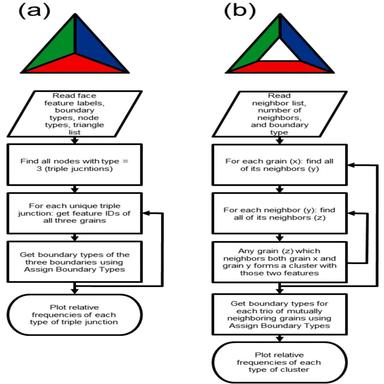
A flowchart representing the algorithm for finding the frequencies of different 3 grain clusters (a) based on triple junctions (b) based on groups of three mutually neighboring grains. The method in (a) requires that all three grains meet at a triple junction as shown in the triangle in (a) while the method in (b) does not necessarily require all three grains to meet such as the schematic at the top of (b).